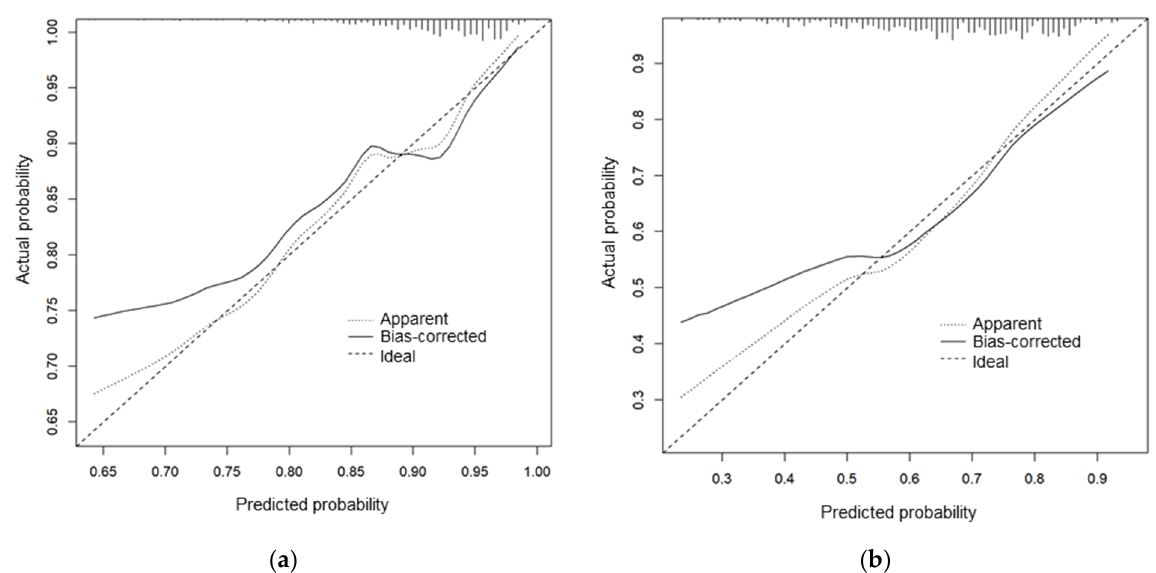
Figure 2. Calibration slopes for successful extubation ( a ) and uneventful extubation ( b ) based on the POSE model. The calibration slopes show the association between the actual probabilities of the events in the cohort (vertical axis) and the probabilities predicted by the POSE model (horizontal axis). We plotted the apparent line (Apparent) and the bias-corrected line (Bias-corrected). These lines indicated that the predicted probability does not deviate substantially from the actual probability of event occurrence. POSE, Prediction of Successful Extubation.